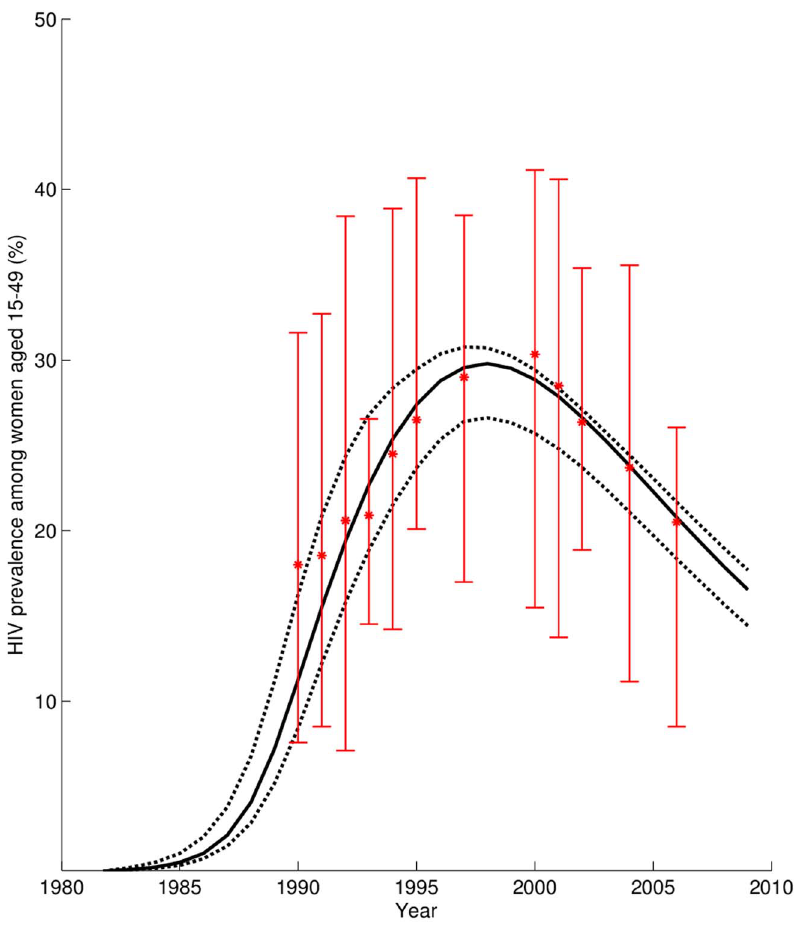
Figure 2. Comparison of model predictions to Zimbabwe antenatal clinic data for non-urban areas [ 17 ] . The solid line represents the yearly HIV prevalence as estimated by our model from baseline epidemiological parameters (dotted lines are the 2.5 th and 97.5 th percentile values). Empirical HIV prevalence is shown as stars (error bars are the 95% confidence intervals). The model was validated from antenatal clinic data not originally used for model parameterization.